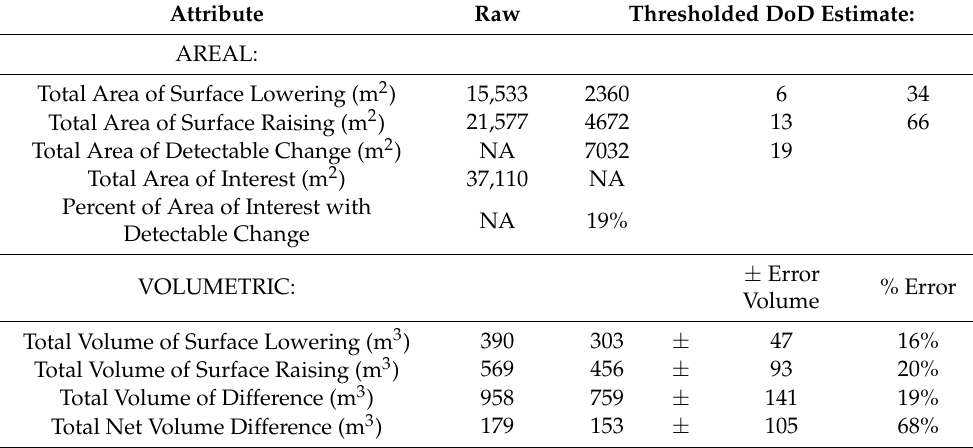
Table 3. Geomorphic changes in the Scott River alluvial fan non-flooded area (AoI NFA ) during the August 2013 flood event calculated using the DoD method in GCD software. Uncertainty was cal- culated using a minimum detection level (minLoD) of 0.02 m.